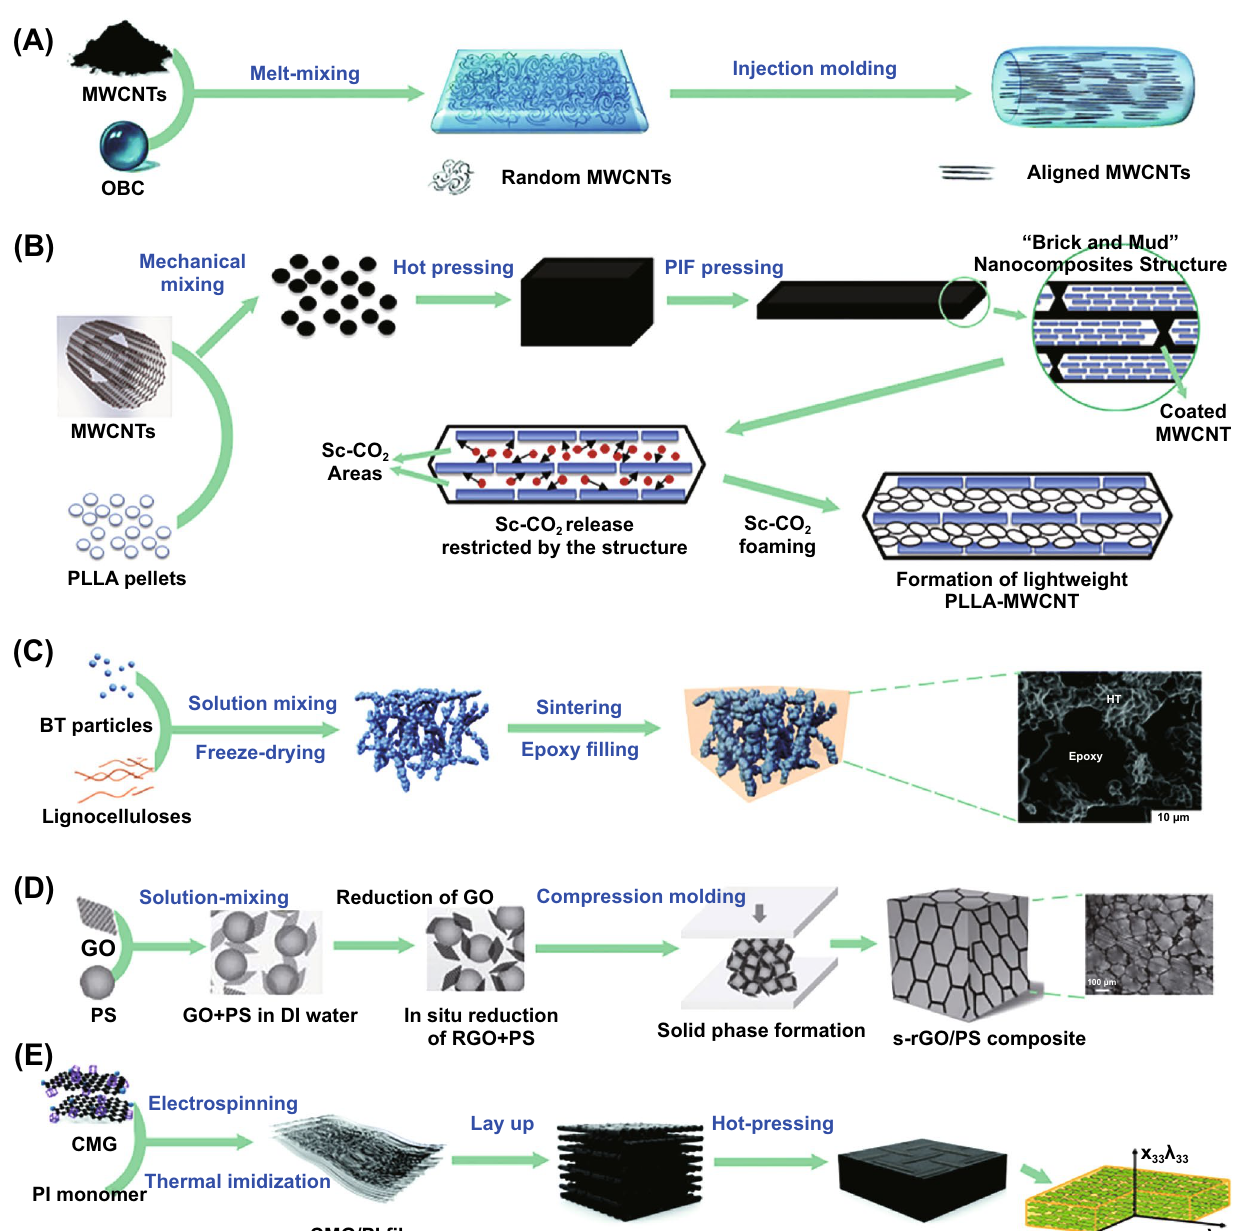
Fig. 1 A Schematic for the preparation and morphology of ethylene-α-octene block copolymer (OBC)/multi-walled carbon nanotubes (MWC- NTs) via melt blending and injection molding. Reprinted with permission from Ref. [17]. B Schematics of using pressure-induced flow (PIF) and supercritical carbon dioxide (Sc-CO 2 ) to prepare poly(l-lactide) (PLLA)/MWCNTs foams. Reprinted with permission from Ref. [18]. C Schematic illustration of the epoxy/BaTiO 3 (BT) composites fabrication process through solution blending BT with lignocellulose, freeze drying, sintering and filling with epoxy in sequence. Reprinted with permission from Ref. [19]. D Schematic of the fabrication and structure reduced graphene oxide/polystyrene (rGO/PS) composites by in-situ reduction following high-pressure solid phase formation. Reprinted with permission from Ref. [20]. E Schematic diagram for the fabrication of chemically modified graphene/polyimide (CMG/PI) nanocomposites with laminate structures by electrospinning–hot pressing method. Reprinted with permission from Ref.